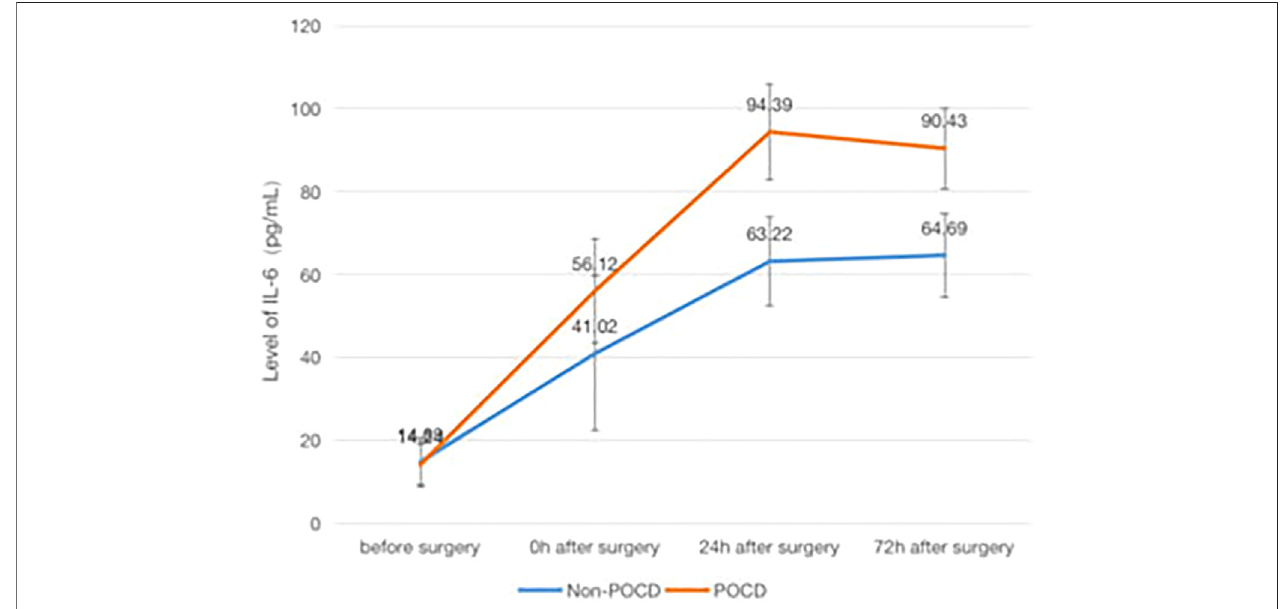
FIGURE 3 | Comparison of serum concentrations of IL-6 (pg/ml) between Non-POCD and POCD groups before and after surgery 丨 There was no signi fi cant difference in the preoperative levels of IL-6 concentration in the Non-POCD group compared with postoperative levels. There was no signi fi cant difference in the preoperative levels of IL-6 concentration in the Non-POCD group compared with POCD group. Compared with preoperative levels, the levels at 24th and 72nd hours after surgeries in the POCD group increased with statistically signi fi cance. The differences in the levels of IL-6 concentration between patients in the POCD and Non-POCD groups at the same time points postoperatively were statistically signi fi cant. Values are mean ± SD. n (cid:1) 61. * p < 0.05 vs. the preoperative level of S-100 β ; # p < 0.05 vs. the POCD group.